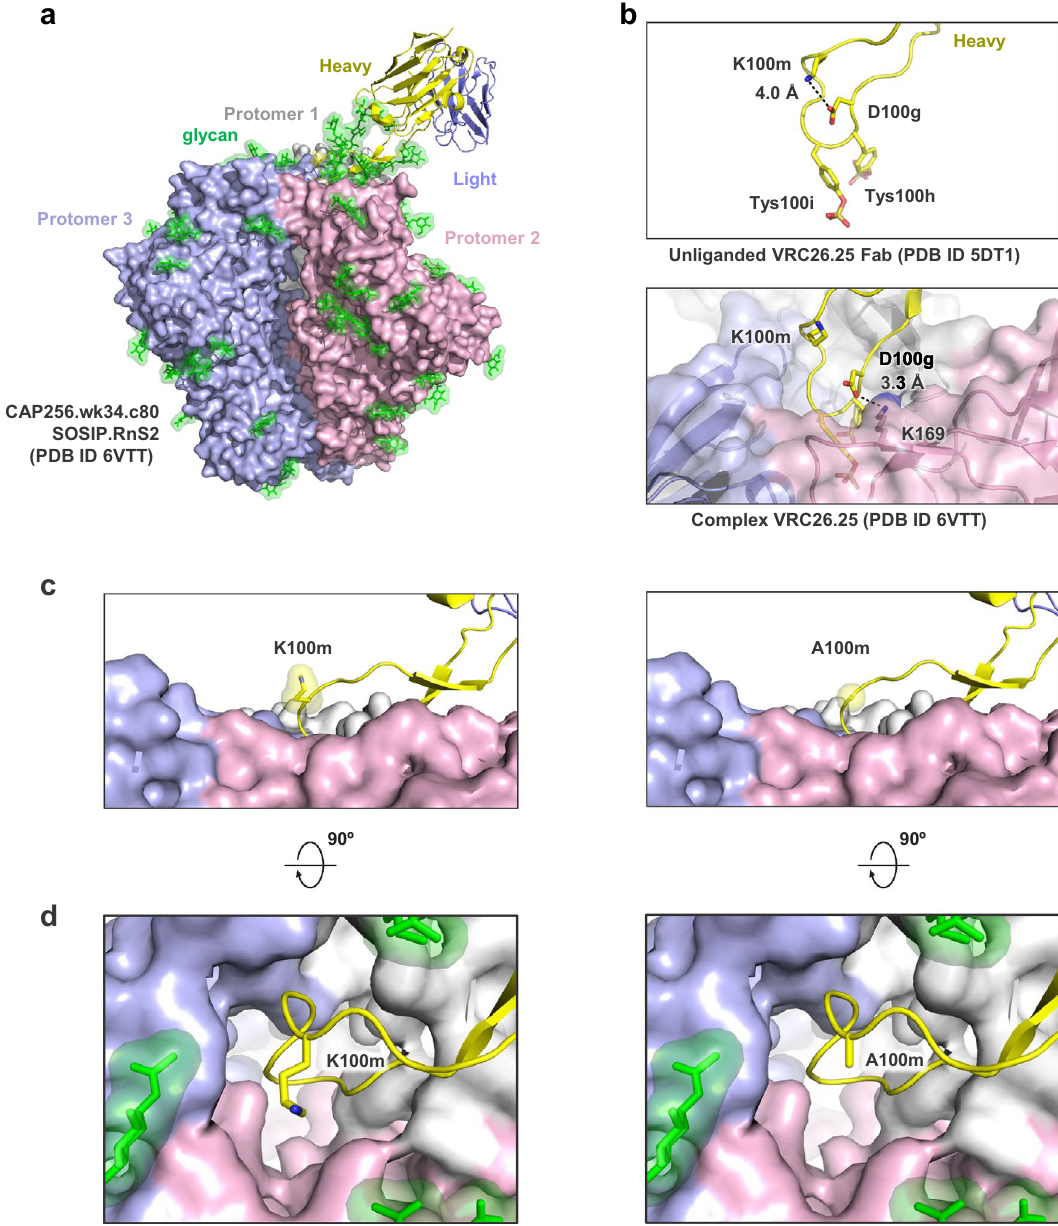
Figure 4. Position 100m in the CAP256-VRC26.25 CDRH3 does not contact the HIV-1 Env. ( a ) Cryo-EM structure of CAP256-VRC26.25 in complex with the CAP256.wk34.c80 SOSIP.RnS2 Env trimer. Trimer is shown in surface rendering, with protomers in grey, pink, and light blue; glycans in green; antibody heavy chain in yellow ribbon, light chain in slate ribbon. ( b ) Close-up of the unliganded CDRH3 conformation, highlighting the K100m contact with D100g (top) in contrast to the bound Fab where D100g is making electrostatic contacts with K169 of the Env. ( c ) (left) K100m is located above the central cavity in the Env apex facing the solvent. (right) modeled alanine at position 100m indicates no addition or loss of Env contacts. ( d ) The central cavity relative to position 100m is shown at a 90° rotation from ( c chilled at 4 °C (0 h) as a control; and then purified using small ProA columns. The purified mAbs were then tested on GX II under reducing conditions to monitor % heavy chain cleavage 12 . For GXII assay, 8ug of protein was treated with 30 mM DTT (reducing) in sample buffer containing SDS and were denatured and reduced at 90 °C for 5 min. Protein was then subjected to capillary gel electrophoresis (CGE-SDS) and results were analyzed using Perkin Elmer GXII software. %Heavy chain cleaved peaks were calculated by relative peak area of cleaved peaks to total peak area of heavy and light chain in the reduced sample.